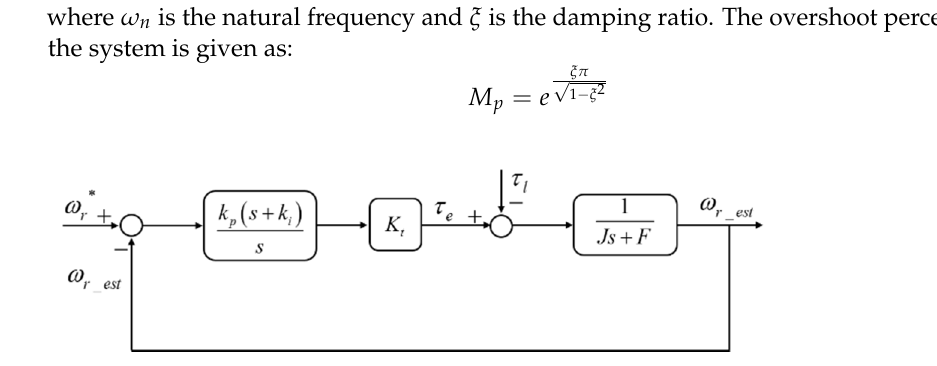
Figure 9. Simplified block diagram of speed controller.